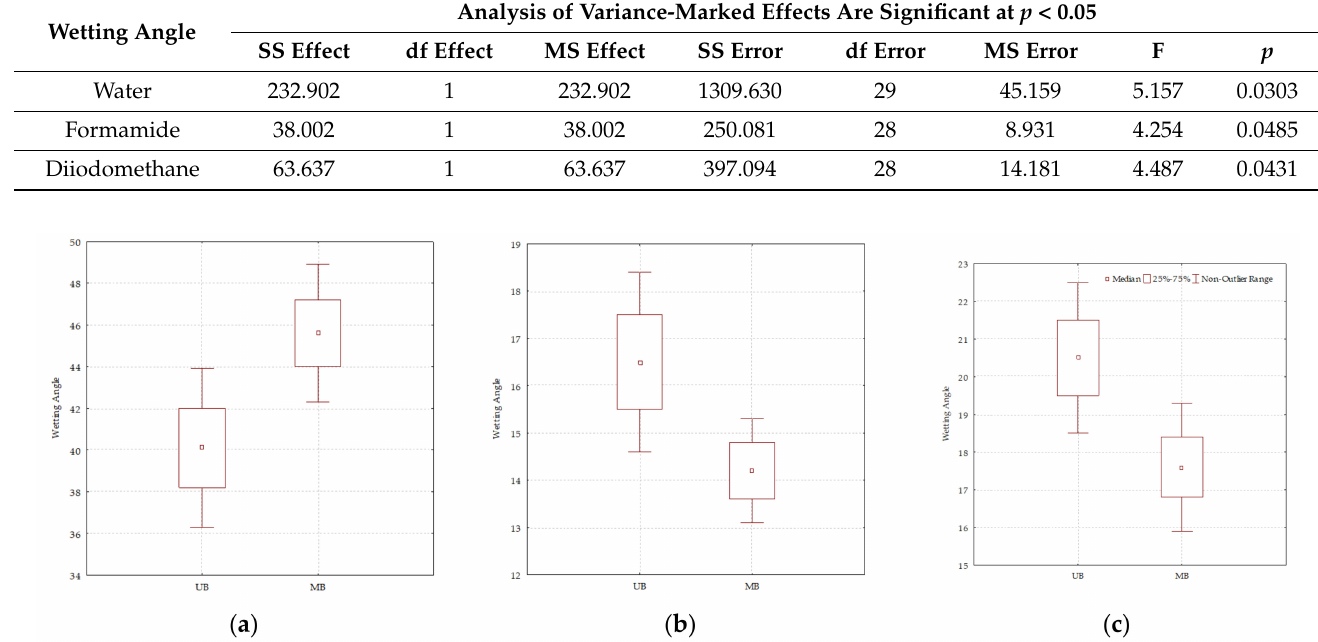
Table 3. Variance analysis of wetting angles measurements.